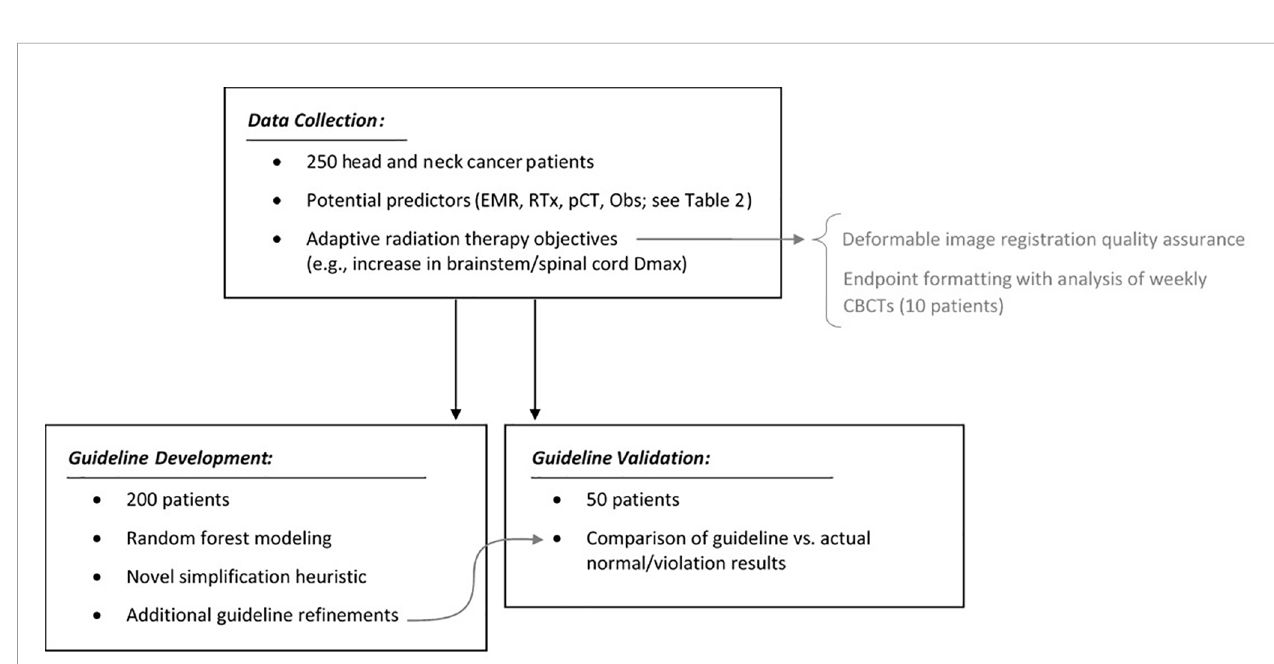
FIGURE 3 | Summary of the study design: data collection, auxiliary analyses, guideline development, and guideline